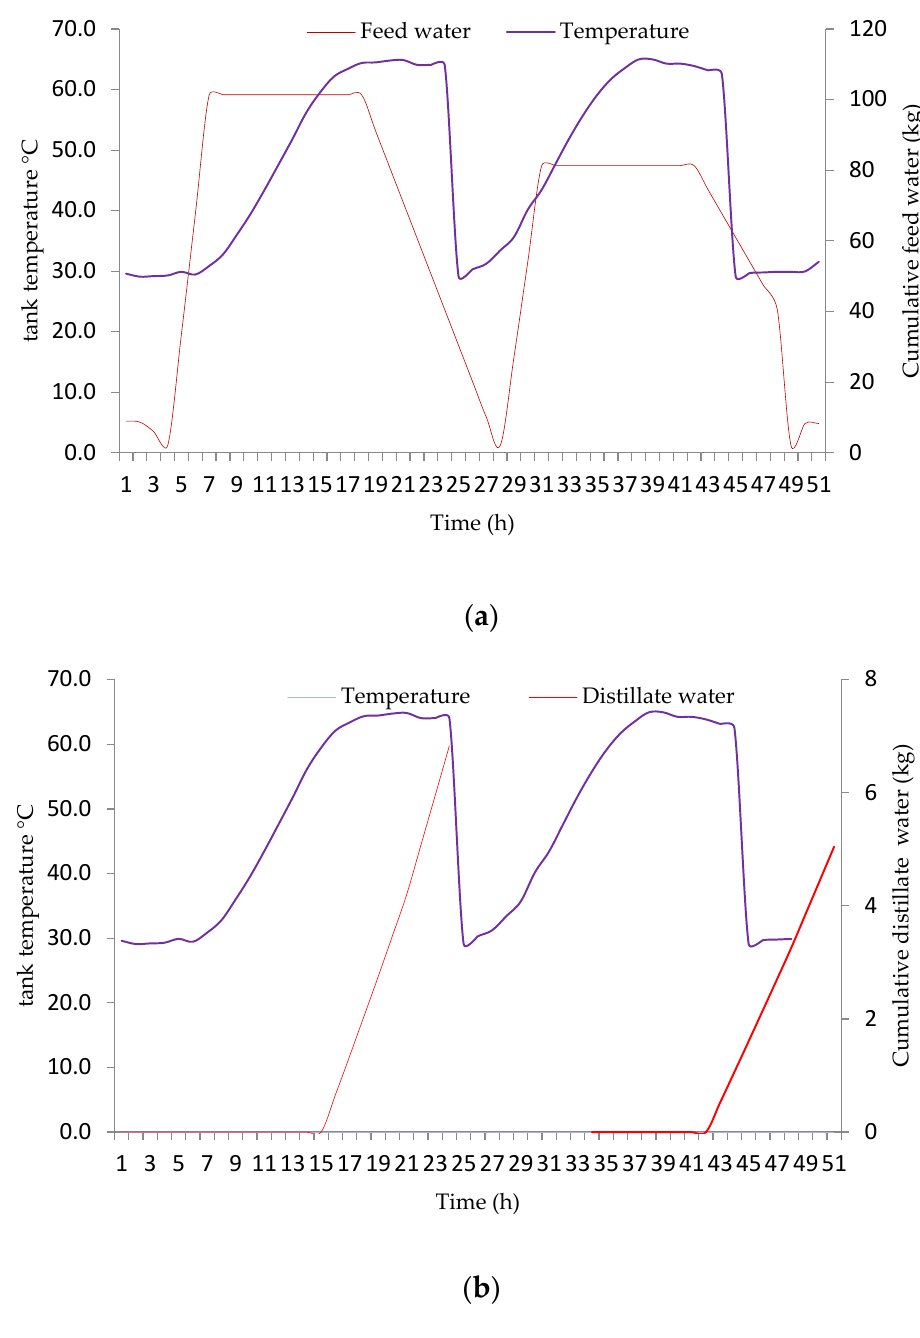
Figure 6. ( a ) Profiles of temperature in the storage tank and feed water for a useful heat of 15 kW. ( b ) Profiles of temperature in the storage tank and variation of production masses for a useful heat of 14.3 kW.